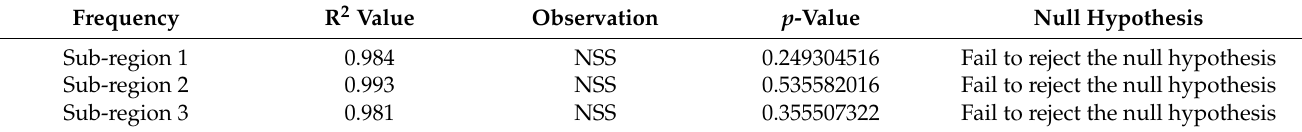
Table 4. Case study 1 ANOVA results.